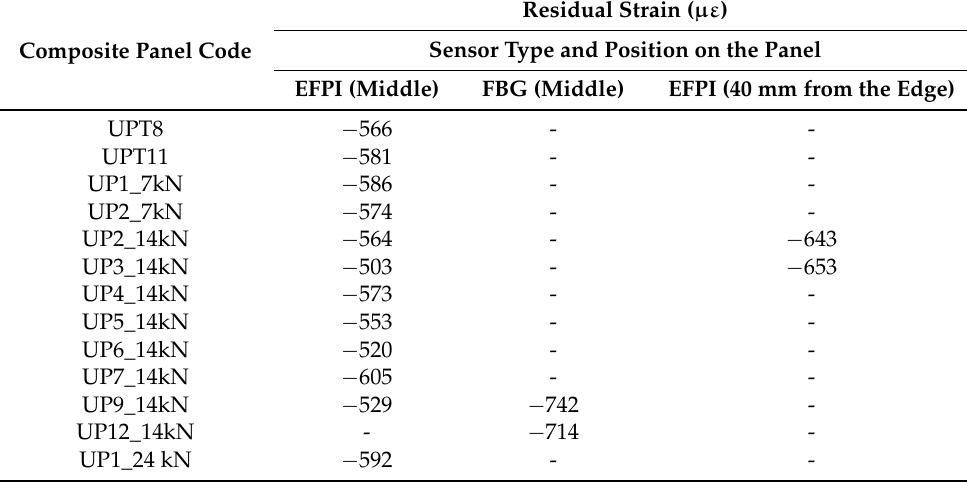
Table 4. EFPI and FBG-based strain data from unidirectional composites that were pre-stressed via thermal expansion of the rig, and applied pre-load values on the preforms corresponding to 7, 14 and 24 kN. The strain data were acquired at room temperature.